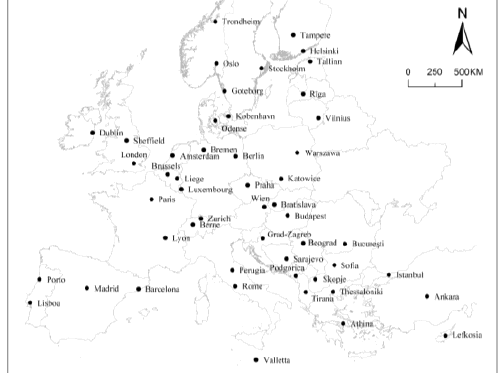
Figure 2 . Locations of the 50 pan-European